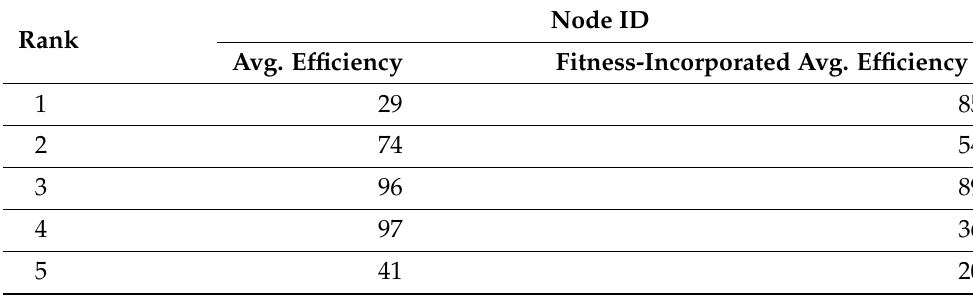
Table 1. Rankings of nodes based on each robustness method in the scale-free network with 100 nodes and 130